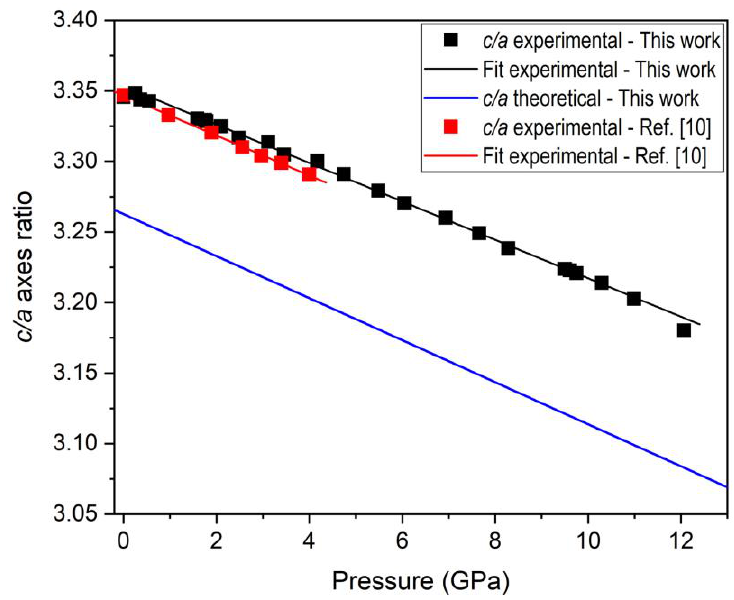
Figure 4. Relative axial compressibilities of the iron-rich ankerite structure. Experimental relative contractions a / a 0 and c / c 0 are represented as solid squares and circles, respectively (black: our data; red: data from [10]). Results from DFT calculations for pure CaFe(CO 3 ) 2 ankerite are depicted as blue lines.